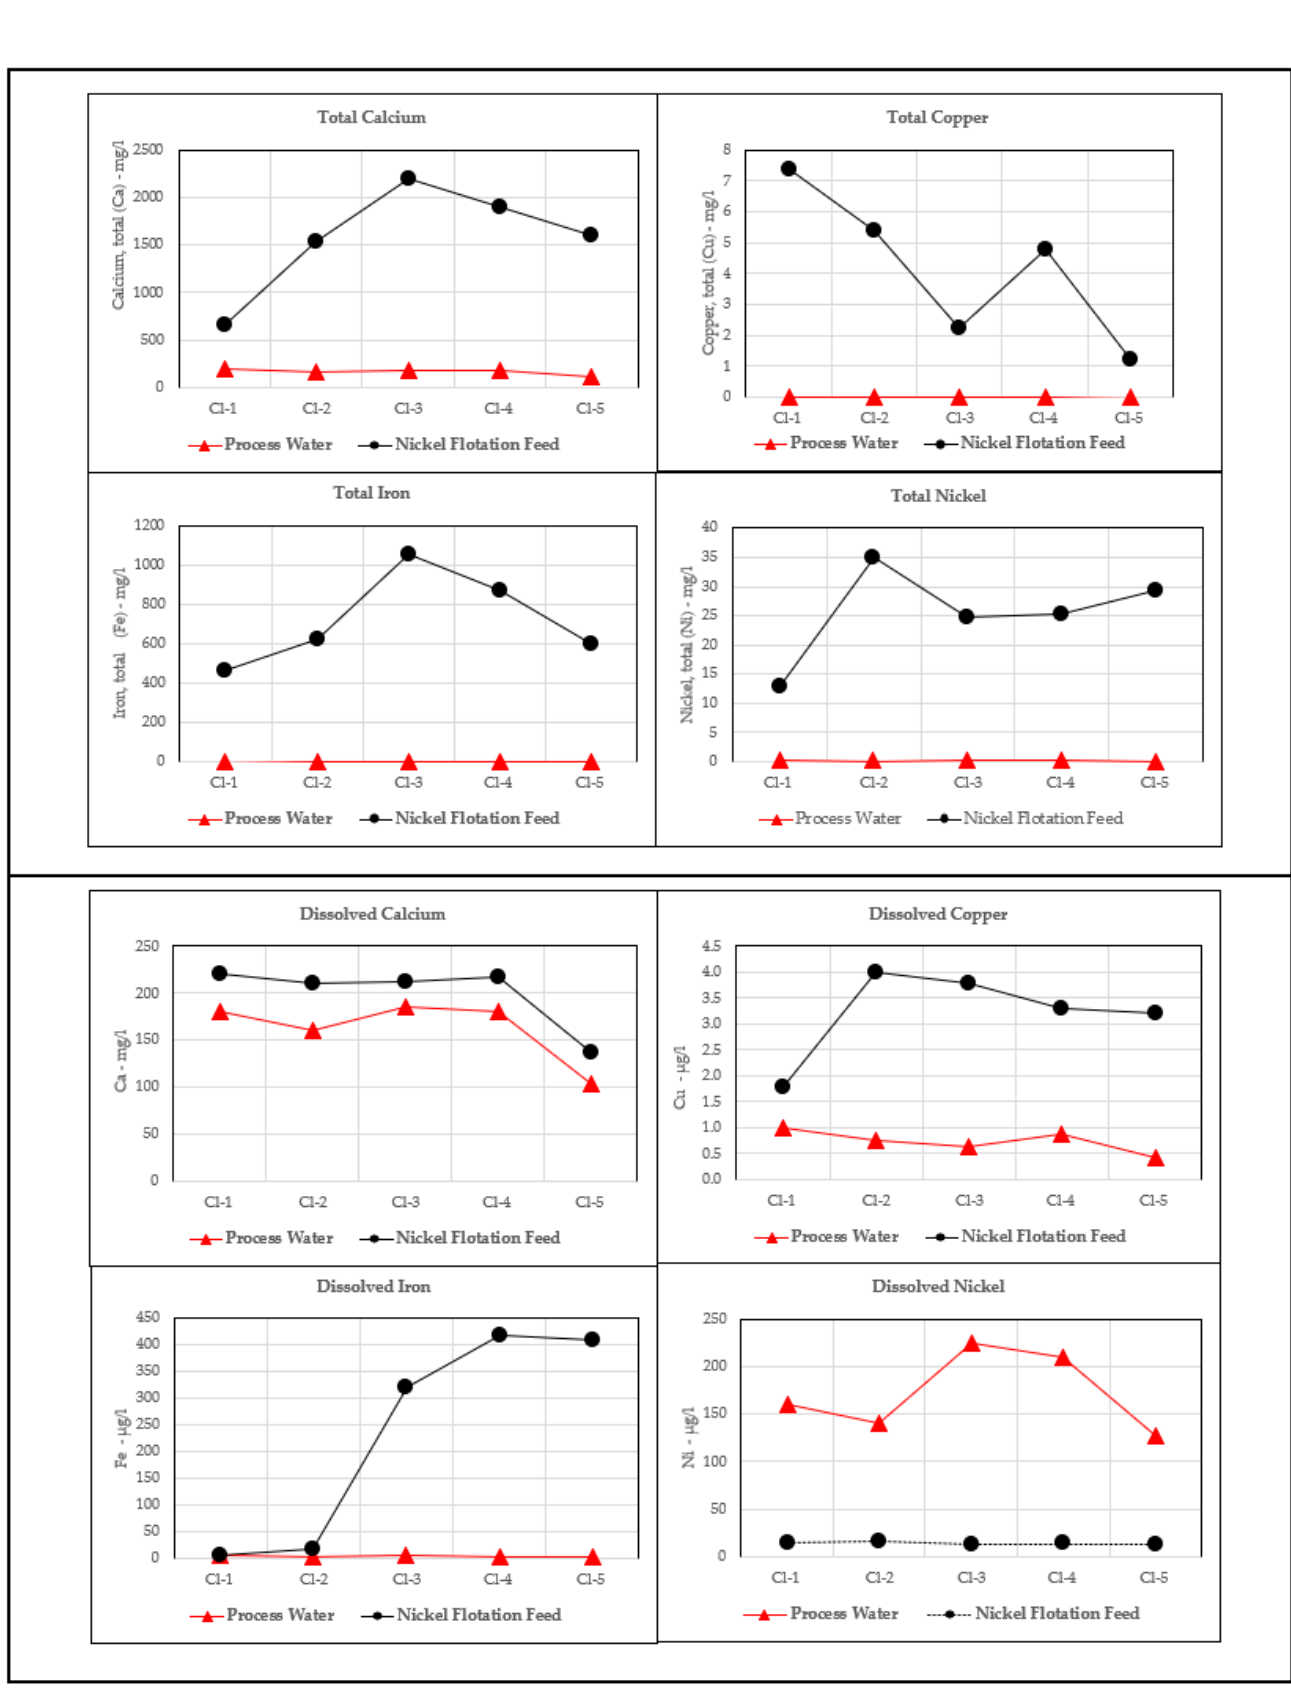
Figure 10. The comparison of the total and dissolved metal concentrations between process water and nickel flotation feed.